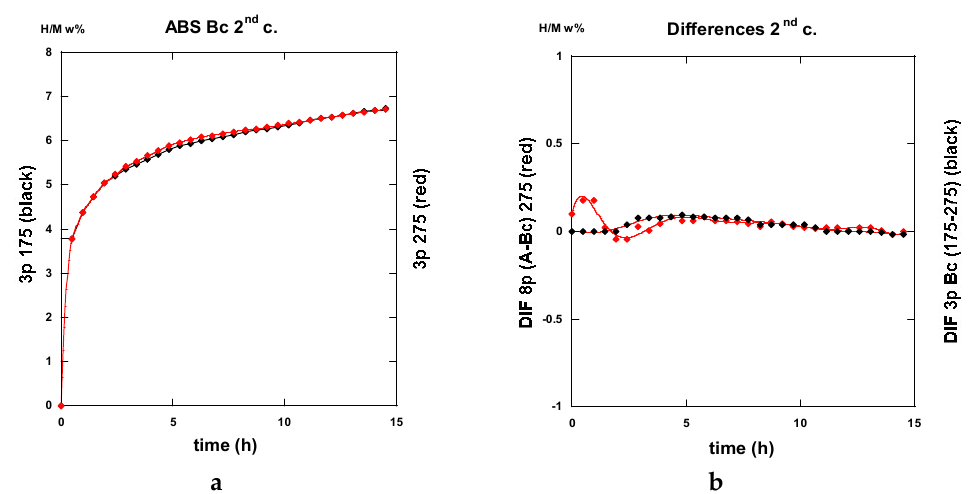
Figure 30 . Second absorption rate traces (H/M w%) of: a —3 passes ECAP treated in B C route at 175° and 275 °C: b —difference between traces A-B C routes for 8 passes at 275 °C and for 3 passes B C between 175 & 275 °C for similar results whatever the treatments are.